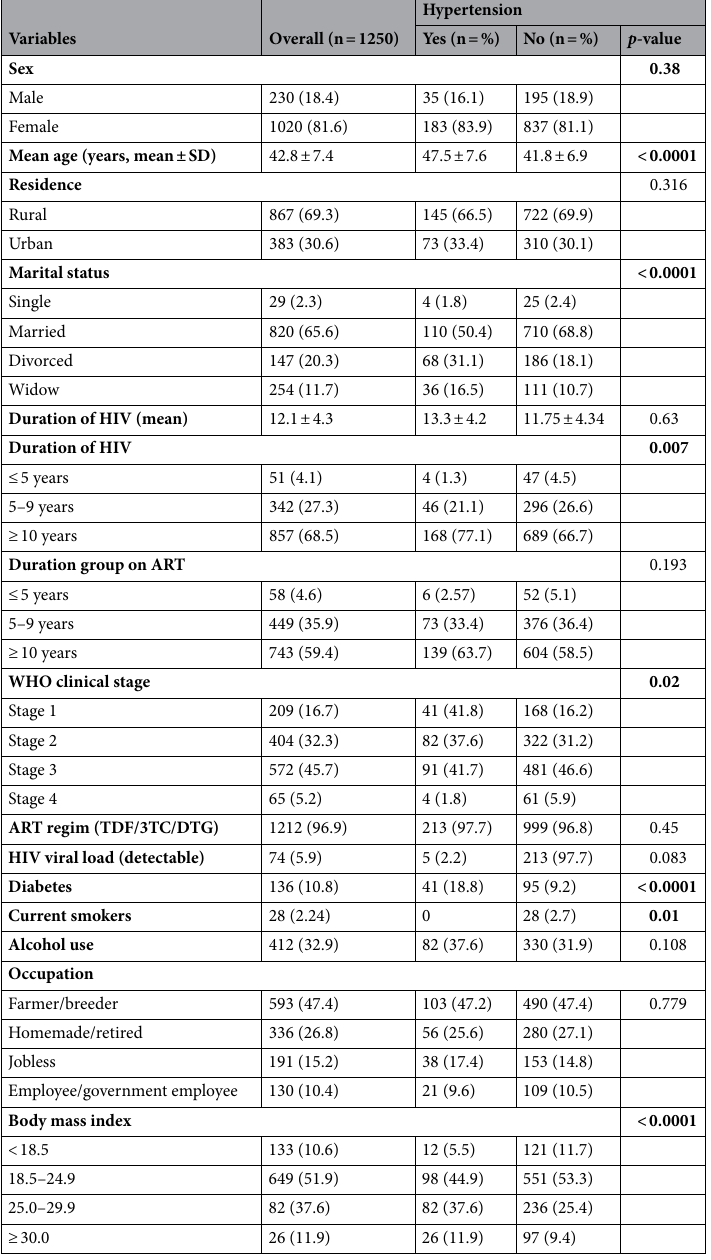
Table 1. Characteristics of HIV infected participants stratified by hypertension status. Significant values are in